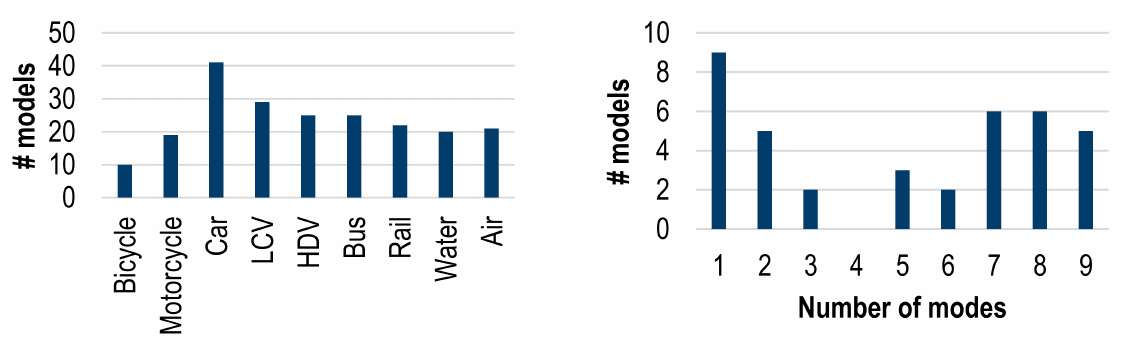
Figure A2. Considered modes in transport sector